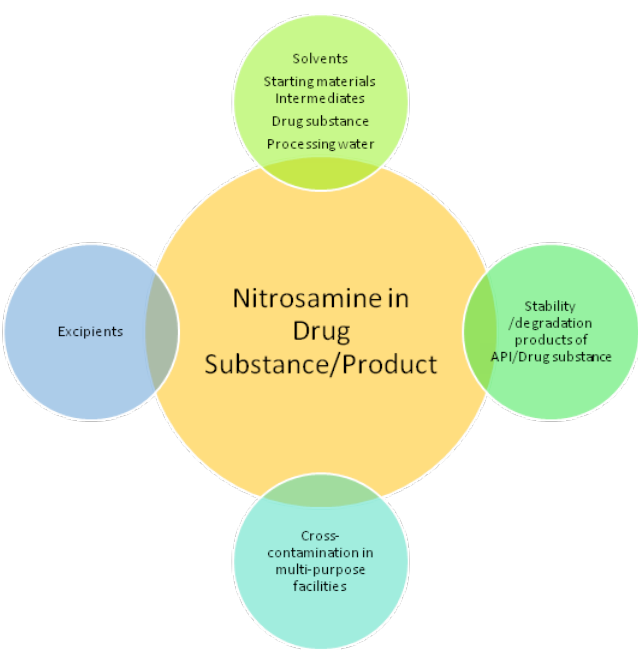
Figure 1. Root causes of nitrosamine impurities in APIs and drug products.